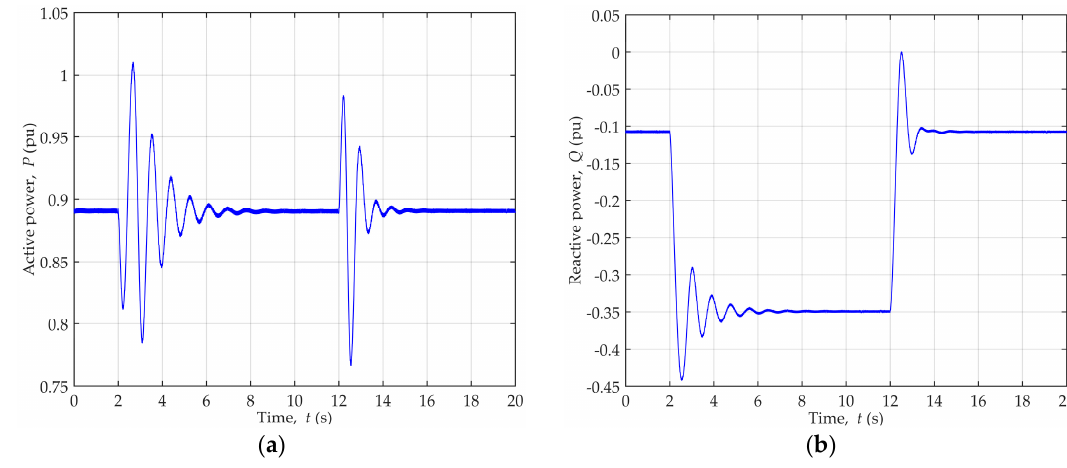
Figure 11. Generator power change during dynamic disturbances of reactive power for generator operating point P = 0.89, Q = 0.11 cap.: ( a ) Active power; ( b ) Reactive power.